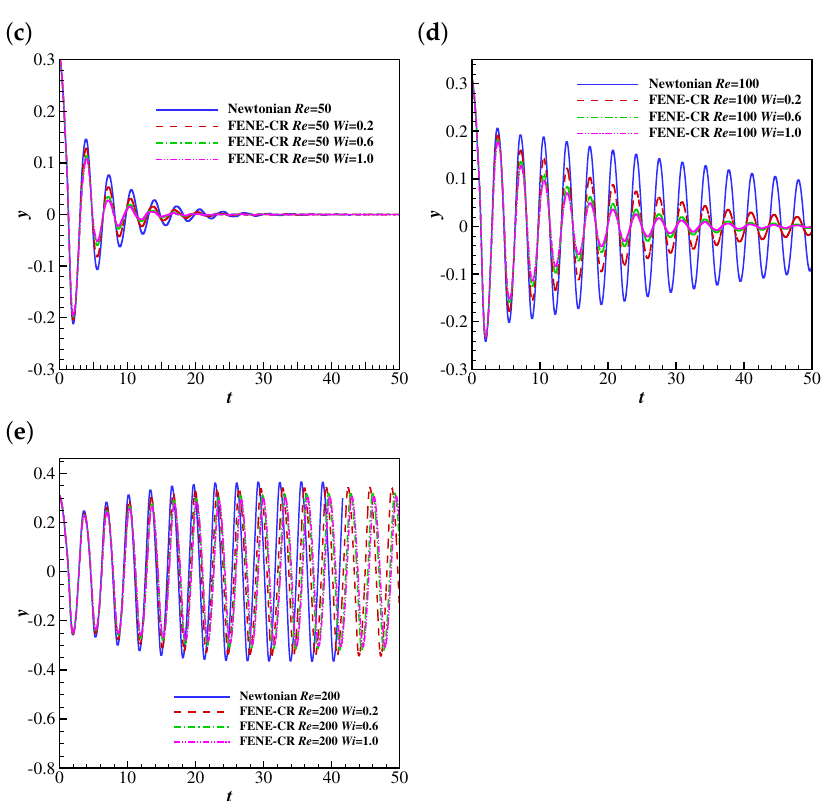
Figure 13. The time histories of the free-end position of the filament in Newtonian and FENE-CR uniform flows at Re = ( a ) 10, ( b ) 25, ( c ) 50, ( d ) 100 and ( e ) 200.